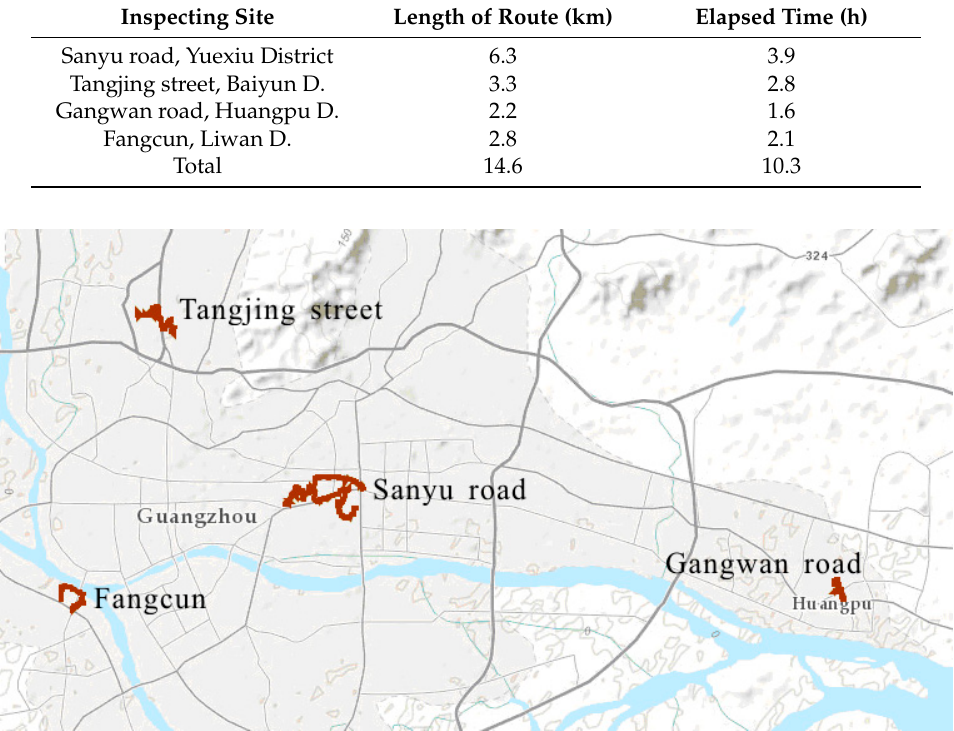
Figure 1. Four study sites (orange lines) in Guangzhou city.